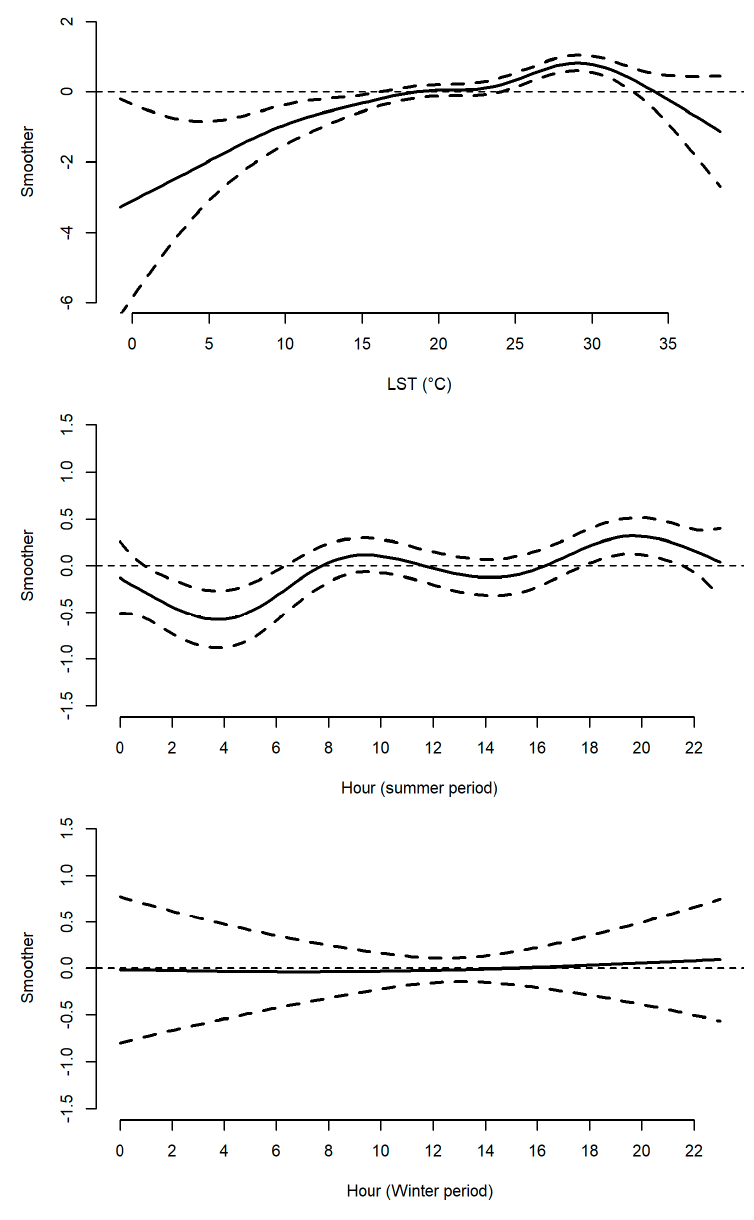
Figure 3. Thin plate splines (y-axis: smoothers) from GAM testing the relationship between ZanzaMapp records of low ( ≤ 3) and high ( > 3) mosquito abundance and human population density, temperature, and hour of the day in 2017 and 2018. LST = land surface temperature. Solid lines represent the mean fitted values, dashed lines represent the 95% confidence